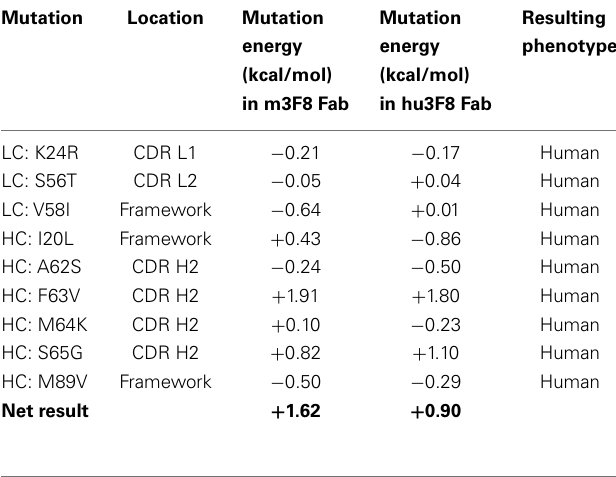
Table 2 | Mutation energies associated with the design of constructV5 .